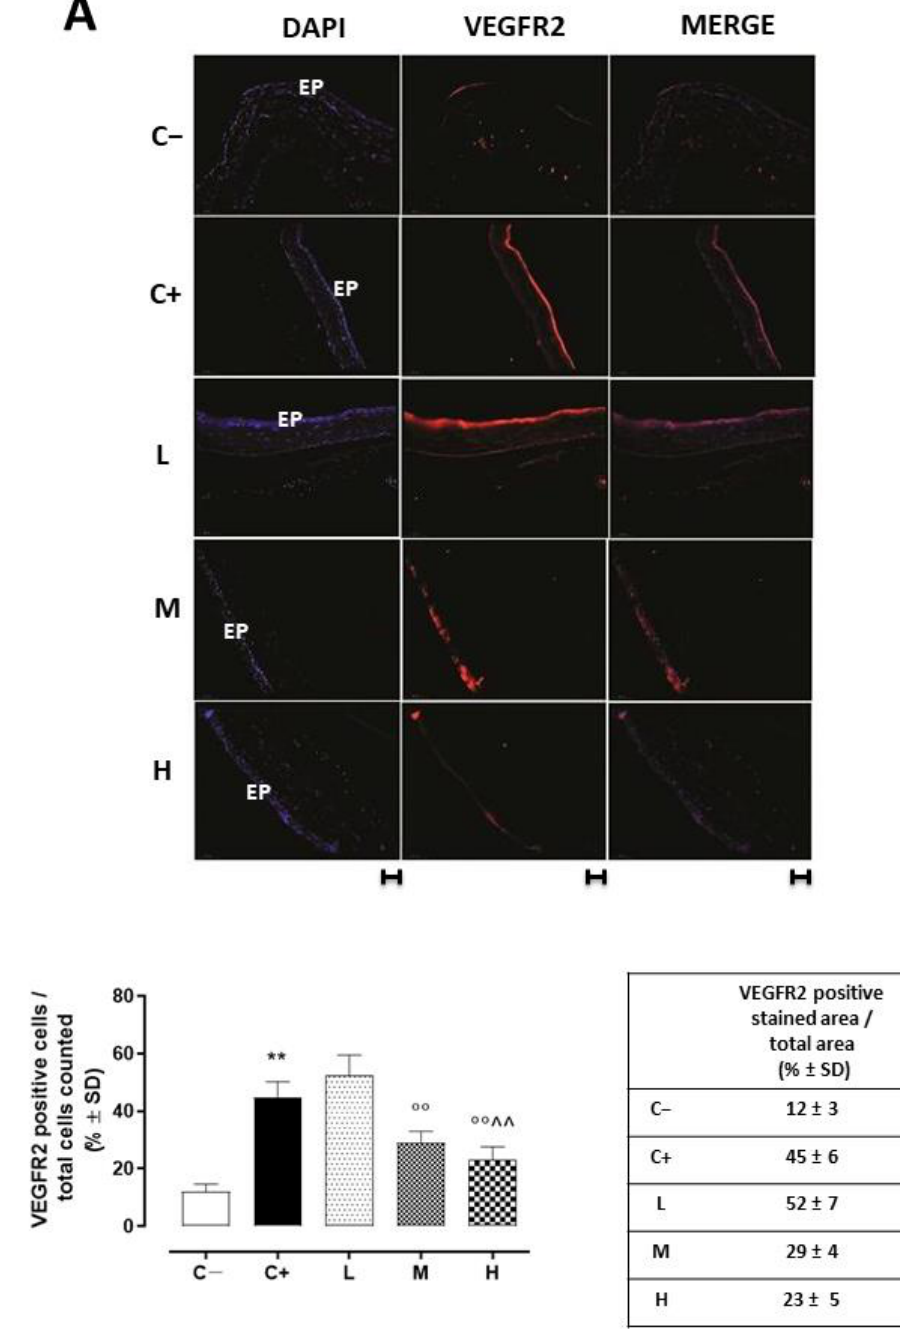
Figure 5. ( A ) Representative immunofluorescence images of the VEGFR2 staining (red) and ( B ) relative quantization, expressed as percentage of the VEGFR2 positive stained area (red)/total cells counted (blue) in the TSP-1 KO mice euthanized at 6 weeks of age as a negative control for SS-associated dry eye (C − ); TSP-1 KO mice euthanized at 12 weeks of age as a positive control for SS-associated dry eye (C+); and TSP-1 KO mice supplied with low (L), medium (M), and high (H) doses of vitamin D3 (1000, 8000, and 20,000 IU/kg/week, respectively) from week 6 to week 12 of age. N = 7 corneas per group; EP: corneal epithelium. Scale bar: 20 µ m; magnification 40 × . ** p < 0.01 vs. C − ; ◦◦ p < 0.01 vs. C+; ˆˆ p < 0.01 vs. L.